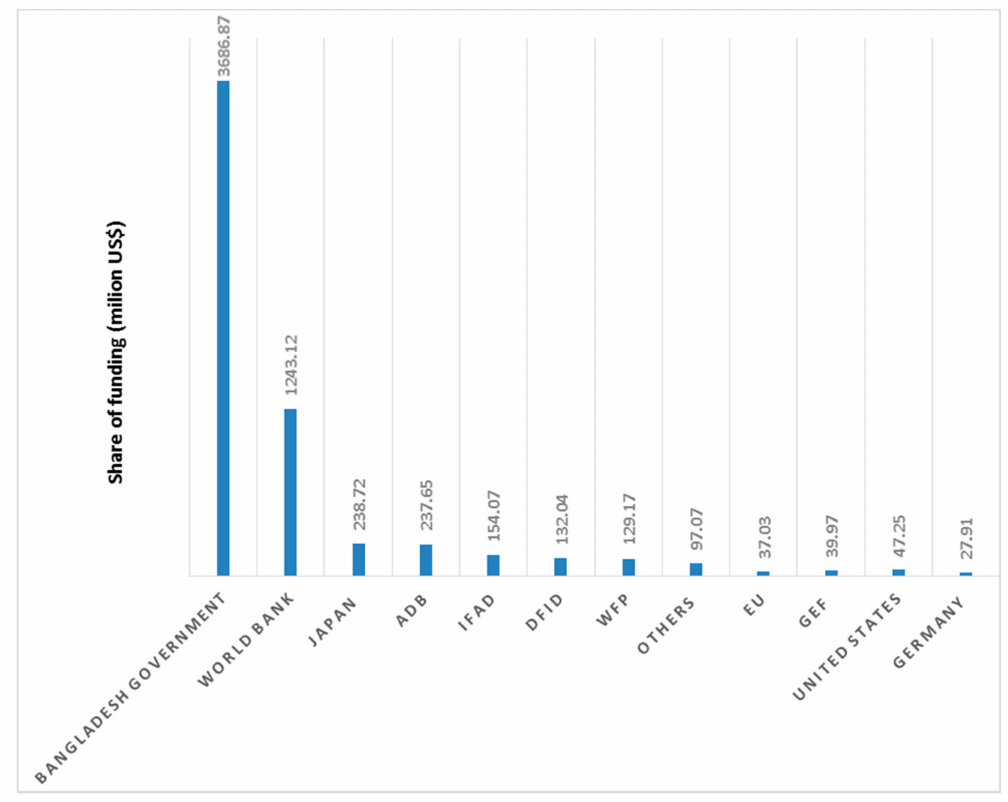
Figure 3. Domestic government versus foreign donors’ funding on climate change